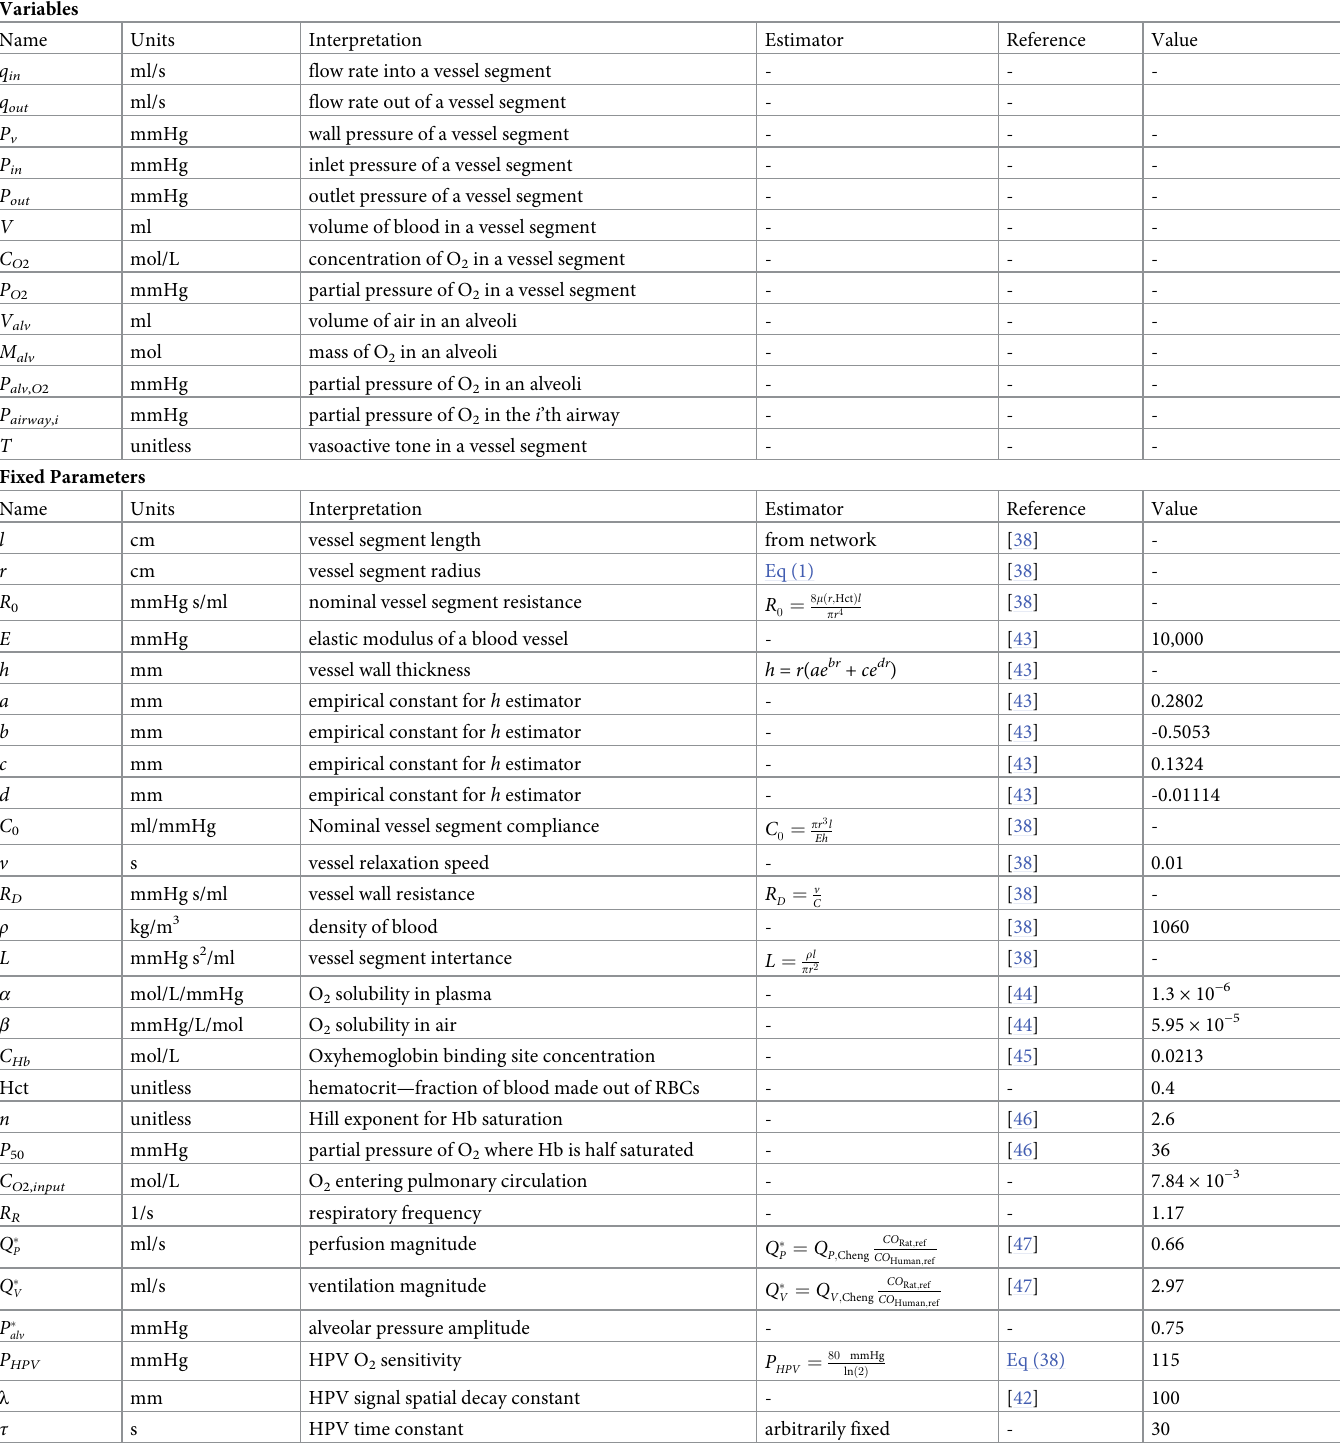
Table 1. Model variables, fixed parameters, and adjustable parameters. Values are omitted if they are time varying or defined for each vessel segment. For the adjustable parameters estimated by the BELUGA Genetic Algorithm, values are reported for each network (A,B,C).